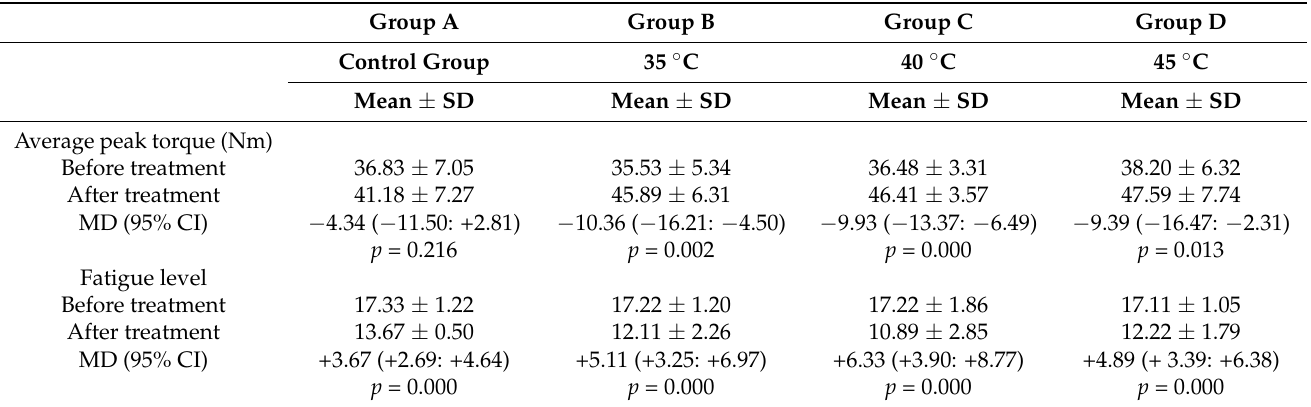
Table 5. Average peak torque and fatigue level before and after treatment within each